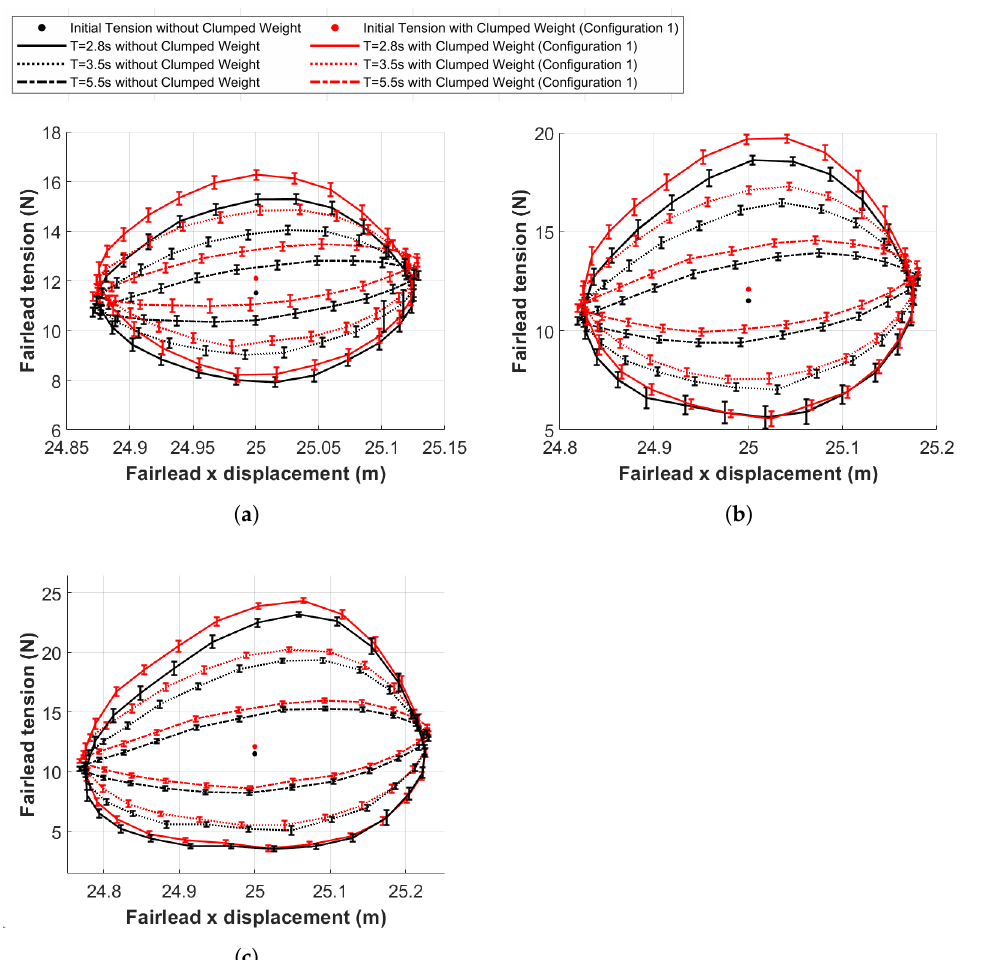
Figure 12. Fairlead tension during the fairlead displacement with and without clumped weight for three different fairlead amplitude values and Configuration 1. ( a ) A = 0.125 m. ( b ) A = 0.175 m. ( c ) A = 0.225